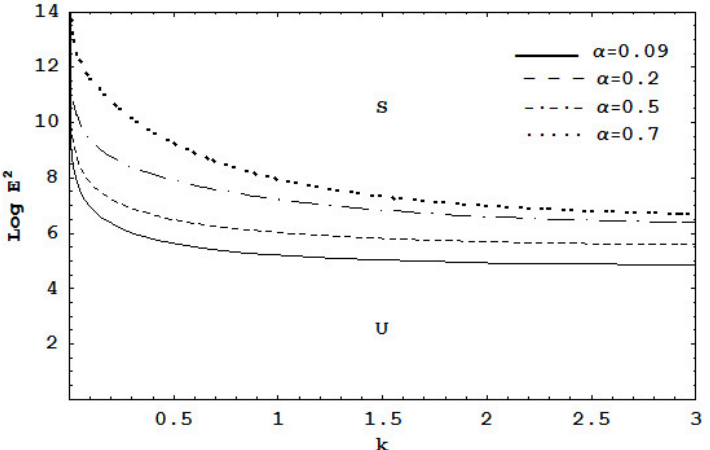
Figure 7. Variation of the electric field intensity log E 2 fluid velocities U 1 , U 2 .